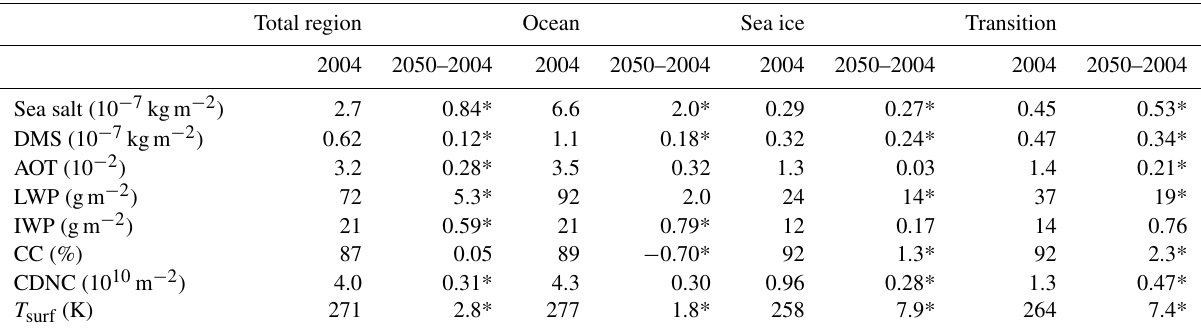
Table 3. As Table 2 but for early autumn